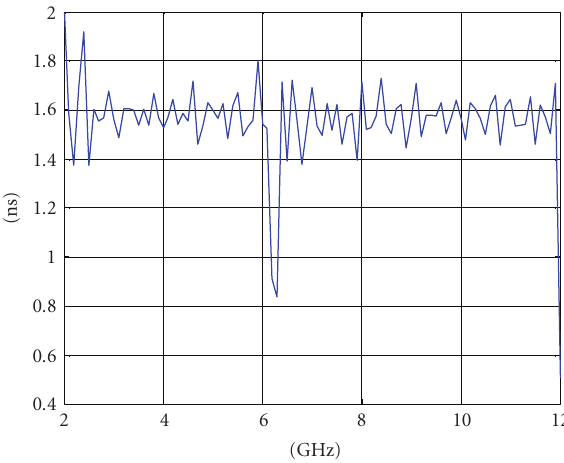
Figure 10: Group delay in the main lobe direction θ = 0 ◦ between 2 and 12GHz.